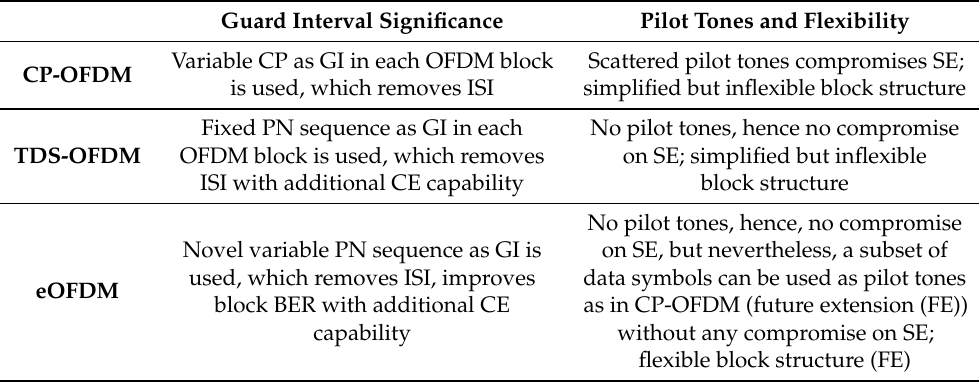
Table 1. Comparison of CP-OFDM, TDS-OFDM and eOFDM salient features. Guard Interval Significance Pilot Tones and Flexibility Variable CP as GI in each OFDM block Scattered pilot tones compromises SE; CP-OFDM is used, which removes ISI simplified but inflexible block structure Fixed PN sequence as GI in each No pilot tones, hence no compromise TDS-OFDM OFDM block is used, which removes on SE; simplified but inflexible ISI with additional CE capability block structure No pilot tones, hence, no compromise Novel variable PN sequence as GI is on SE, but nevertheless, a subset of used, which removes ISI, improves data symbols can be used as pilot tones eOFDM block BER with additional CE as in CP-OFDM (future extension (FE)) capability without any compromise on SE; flexible block structure